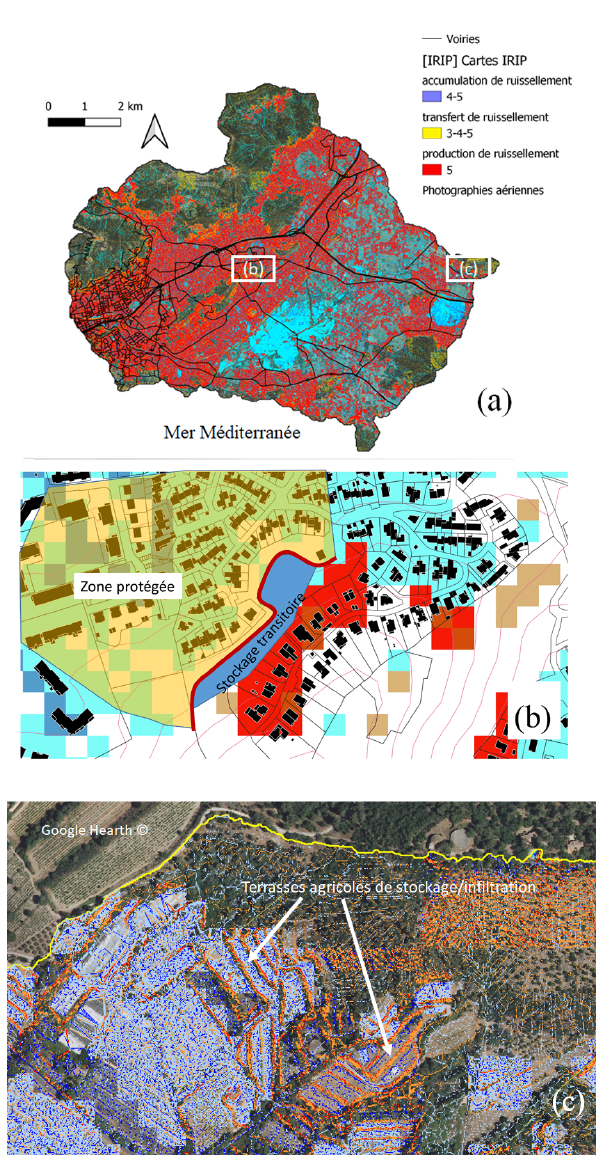
Figure 2. (a, b, c) Localisation des opportunités d’action pour ré- duire l’effet du ruissellement en périphérie de